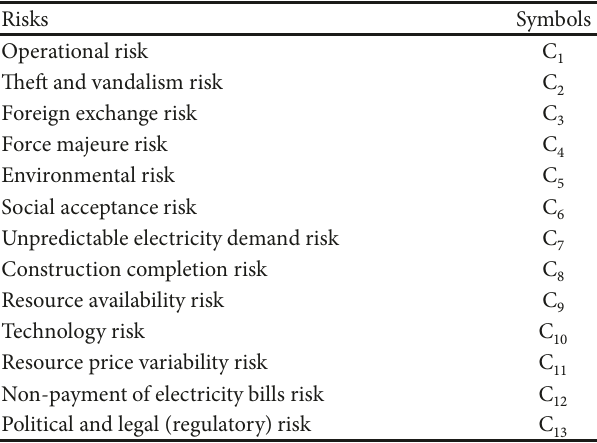
Table 2: Risks for the evaluation of mini-grid energy sources.